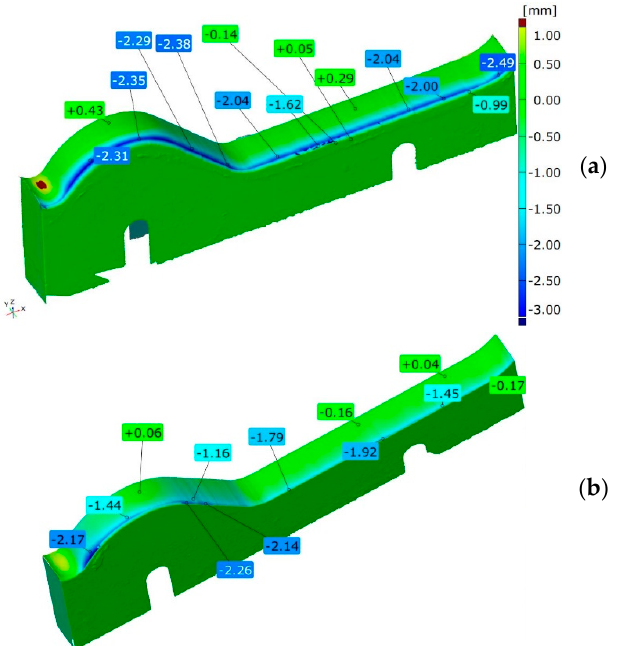
Figure 5. Results of scanning the lower tools made of steel: ( a ) Hardox 600 and ( b ) NC11LV. For the upper inserts (Figure 6), the wear reaches a much higher level than in the case of the lower ones. This is due to the fact that the upper inserts can be adjusted and lowered, if the appropriate, acceptable shape of the tool is maintained of course. The highest wear for the insert made of Hardox steel can be observed on the side of the die of the pug mill. The most intensively worn area is visible on the fragment where the shape of the insert transfers from the “wave” into a flat area. In this section, the wear throughout the whole thickness of the material exceeds 3 mm. The wear reaches its maximum towards the end of the plate fragment and equals about 4.5 mm.